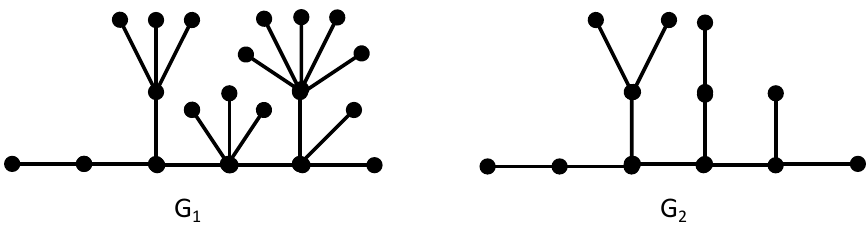
and a restricted thin tree 𝐺 1